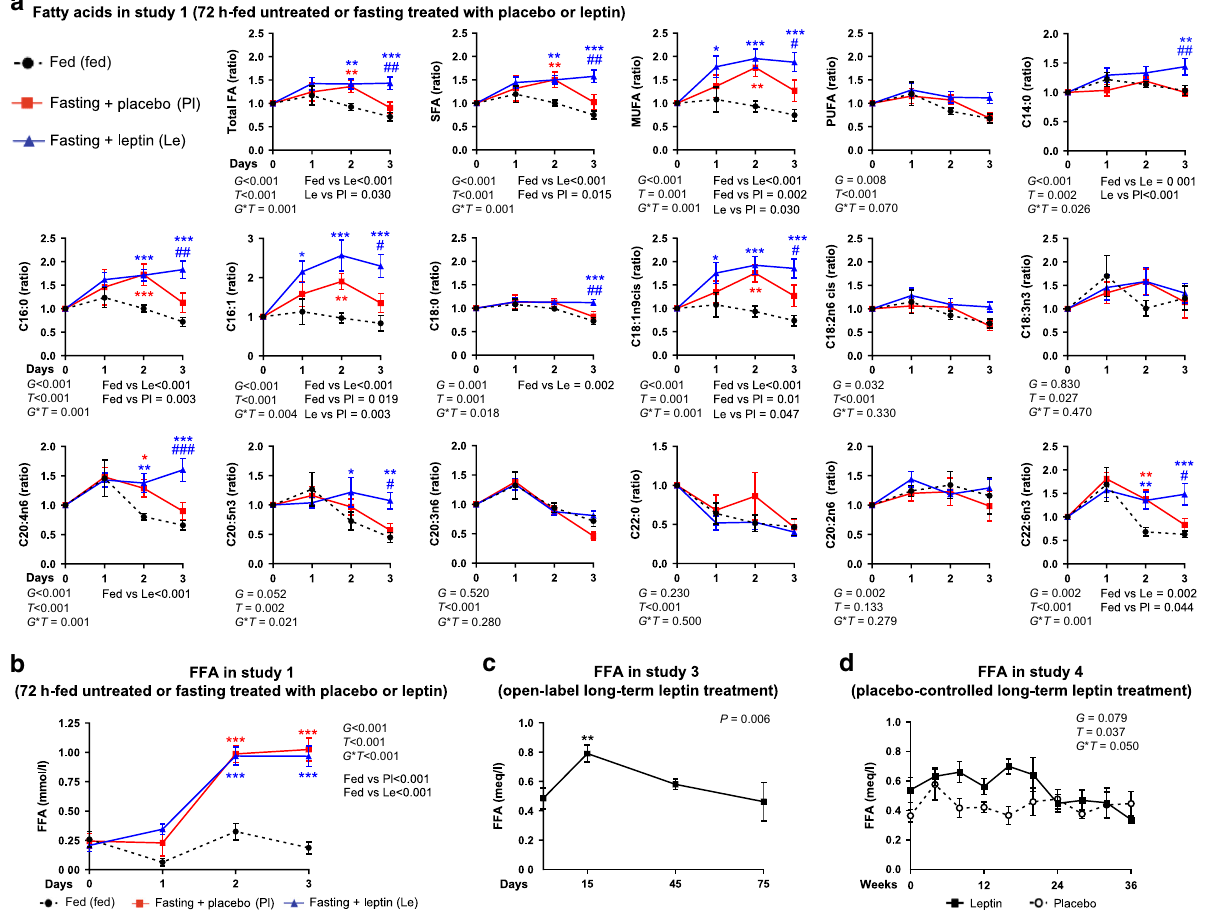
Fig. 7 Fatty acid changes with short- and long-term leptin treatment. a , b Seventy-two hours fed state or fasting + leptin or fasting + placebo (study 1, n = 13). a Blood concentrations of fatty acid pro fi le from start and till completion of the study as ratios of the baseline (0 day). GC/MS-EI was used to quantify fatty acid methyl esters in whole plasma. b Blood-free fatty acids (FFA) from start and till completion of the study; mixed model was performed (for FFA adjusted for baseline). P values of G (group: fed or fasting + placebo or fasting + leptin), T (time: days of study), and G * T interaction of mixed models are reported. In panels a and b by G * T < 0.05, post hoc Bonferroni test was performed between the estimated means of the three groups and between the three groups at each timepoint. One, two, or three asterisks indicate P < 0.05, <0.01, or <0.001 for fed vs fasting + placebo (red) and for fed vs fasting + leptin (blue). One, two, or three hash signs indicate P < 0.05, <0.01, or <0.001 for fasting + leptin vs fasting + placebo in the Bonferroni post hoc t test. c Open-label long-term leptin treatment in mildly hypoleptinemic women (study 3, n = 7). Blood FFA concentrations. P value of time effect (i.e., days of study) of mixed models adjusted for baseline is reported. Two asterisks indicate P < 0.01 for the speci fi c timepoint vs 0 (baseline) in the Bonferroni post hoc t test (performed by P < 0.05). d Placebo-controlled long-term leptin treatment in mildly hypoleptinemic women (study 4, n = 19 (leptin = 10; placebo = 9)). P values of G (group: placebo or leptin), T (time: weeks of study), and G * T interaction of mixed models adjusted for baseline are reported. By G * T < 0.05, post hoc Bonferroni test was additionally performed between the two groups at each timepoint. One or two asterisks indicate P < 0.05, or <0.01 for leptin vs placebo for the speci fi c timepoint. For Bonferroni post hoc tests, only signi fi cant results are reported. All P values are two-sided. Data